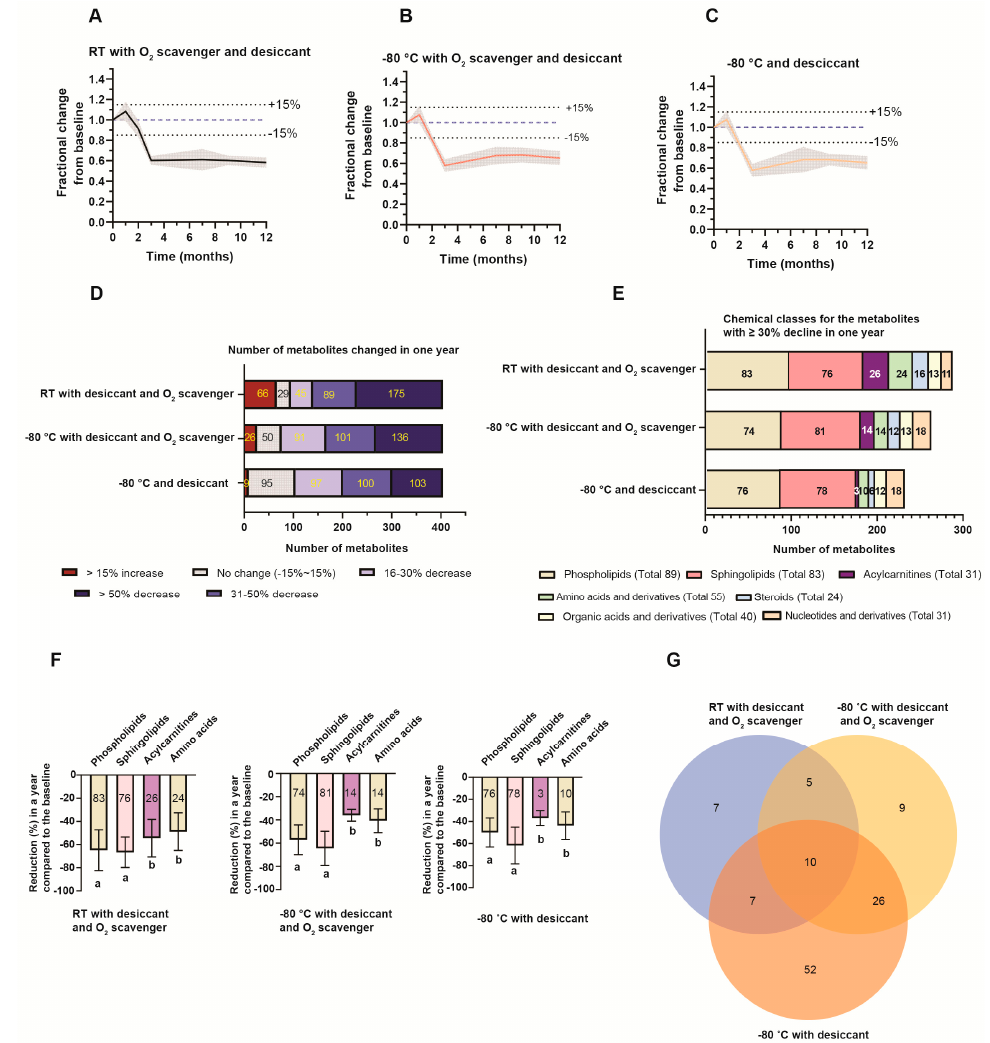
Figure 4. Stability analysis. ( A – C ) The fractional change over a year from the baseline for the geomean of all detected metabolites. ( A ) DBS stored at room temperature (RT) with desiccant and an O 2 scavenger (RT with desiccant and an O 2 scavenger). ( B ) DBS stored in − 80 °C with desiccant and an O 2 scavenger. ( C ) DBS stored in − 80 °C with desiccant. The shaded area represents the standard deviations (SD). ( D ) The number of metabolites altered in a year of storage in different conditions. ( E ) The chemical classes for the metabolites with ≥ 30% decline in one year. The number of metabolites changed was listed in the graph and the total number of targeted metabolites in each chemical class was shown in the legend. ( F ) The percentage of reduction (%) from the baseline for the metabolites in the major chemical classes. The value in the bar graph was the total number of metabolites in each chemical class. A one-way ANOVA followed by Tukey’s test was conducted. Data indexed by di ff erent letters (“a” and “b”) were significantly di ff erent from each other ( p < 0.05) in each storage condition. ( G ) The number of stable metabolites over one year of storage in each storage condition. The names of the stable metabolites